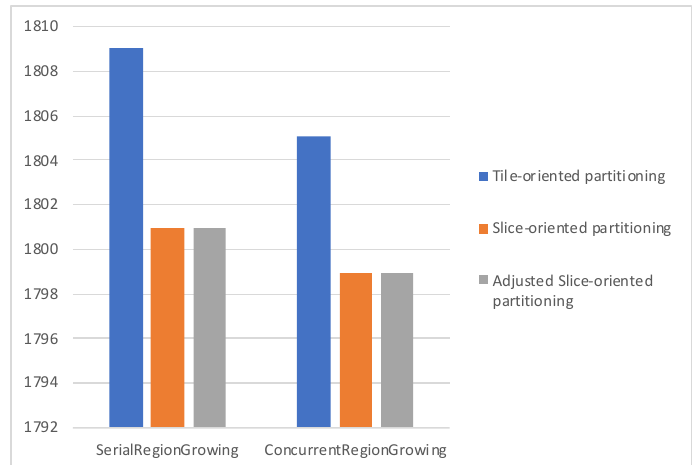
Figure 11. Average bitrate performance for 4